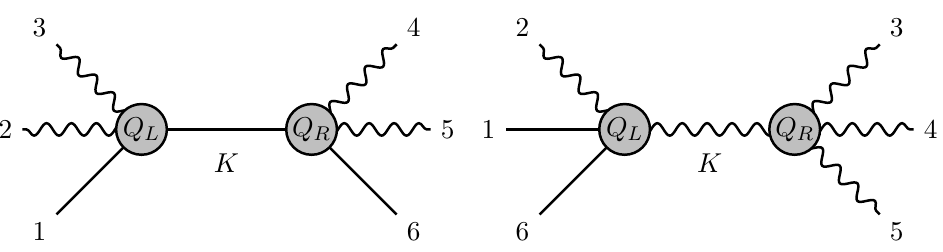
Figure 1 . The vertices, Q L and Q R , represent four-point superamplitudes (cid:14) 8 ( Q L ) and (cid:14) 8 ( Q R ). They are glued together by an on-shell propagator K . The curvy lines denote massless particles in 4D, while the solid line indicates 4D massive particles. In the above diagram, we choose leg-1 and leg-6 to be massive states in